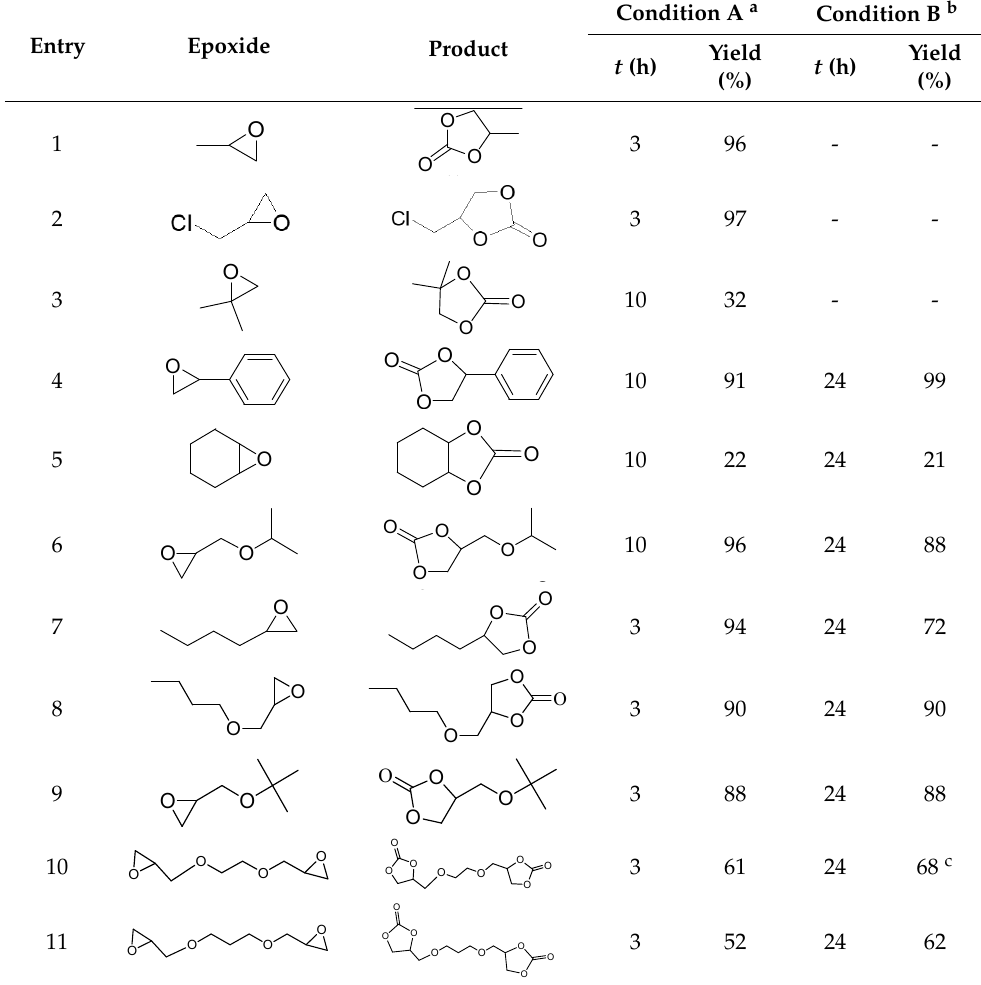
Table 2. Cycloaddition between CO 2 and various epoxides catalyzed by Zn ‐ NPClH. Entry Epoxide Product